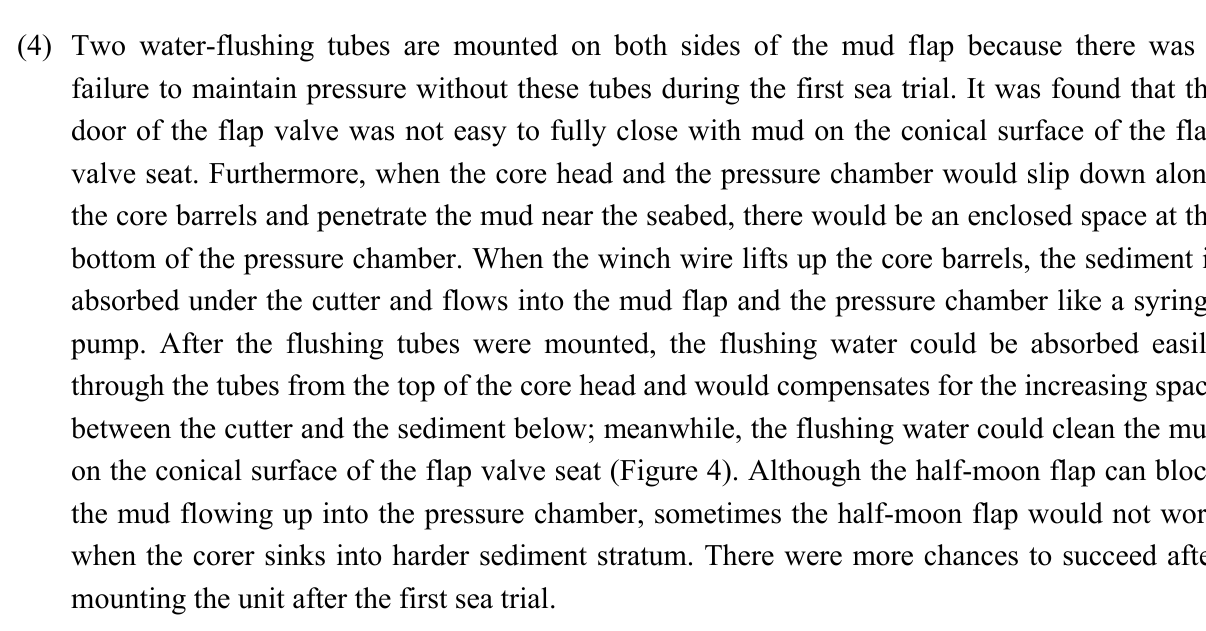
Figure 4. Water-flushing structure: ( a ) When the core barrel lifts up, the slide copper bushings are pushed upward and then pushed radially; then, the half-moon mudflap will close; ( b ) When the mudflap is closing and the core barrels are being lifted up, there is lower pressure, and the water at the top of the core head is absorbed into the space between the cutter and the mudflap through the flushing tubes; therefore the pressure chamber and the core head are not lifted; and ( c ) when the core barrels enter the pressure chamber, the door closes by the spring tension. The flushing water cleans the conical surface of the flap valve seat and the surface of the door; this is important to establish the